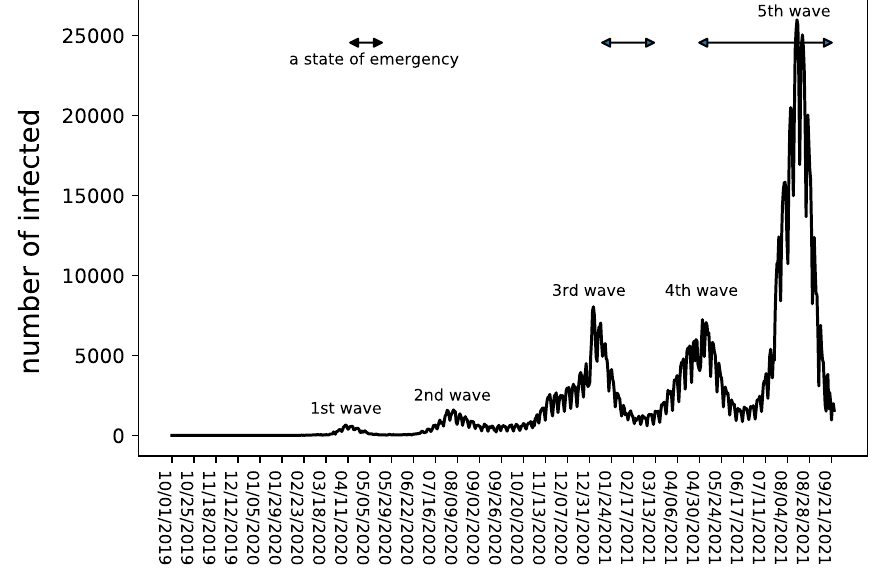
Figure 1. The number of people infected with COVID-19 in Japan. The state of emergencies were declared for the periods indicated by the